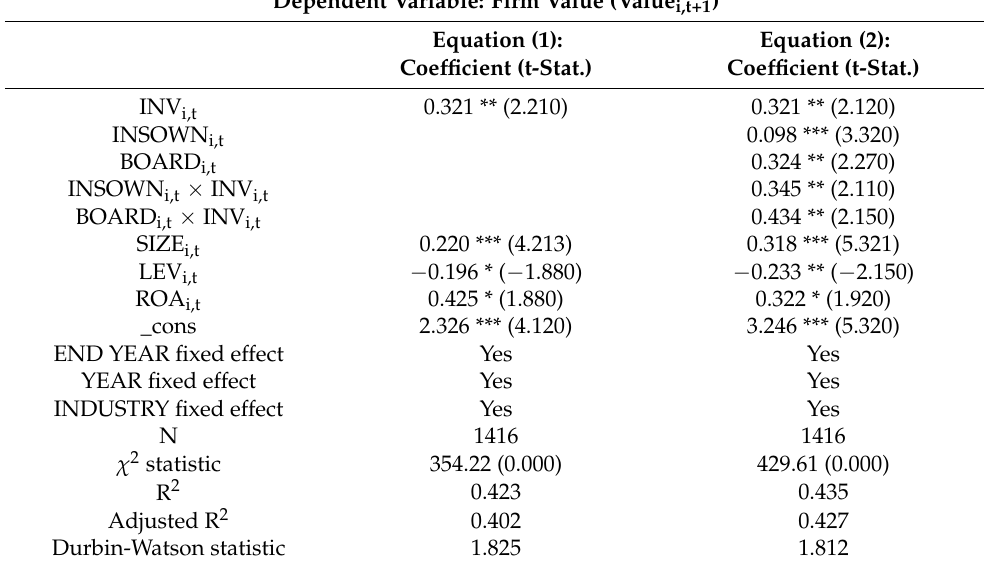
Table 6. t + 1 regression for the impact of investment efficiency, institutional ownership, and board independence on firm